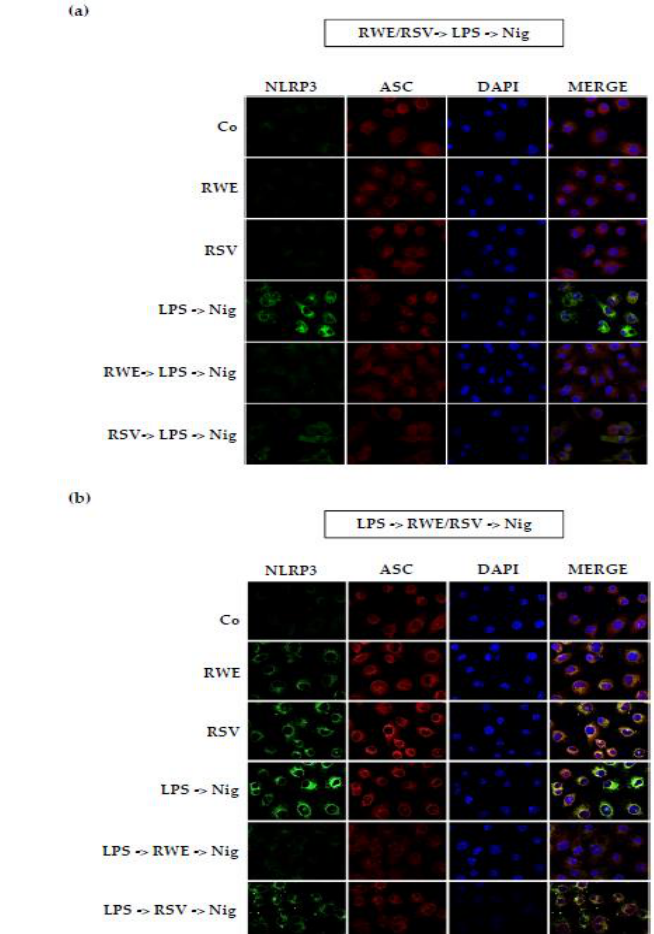
Figure 6. RWE and RSV decrease NLRP3 and ASC colocalization in both priming and activation